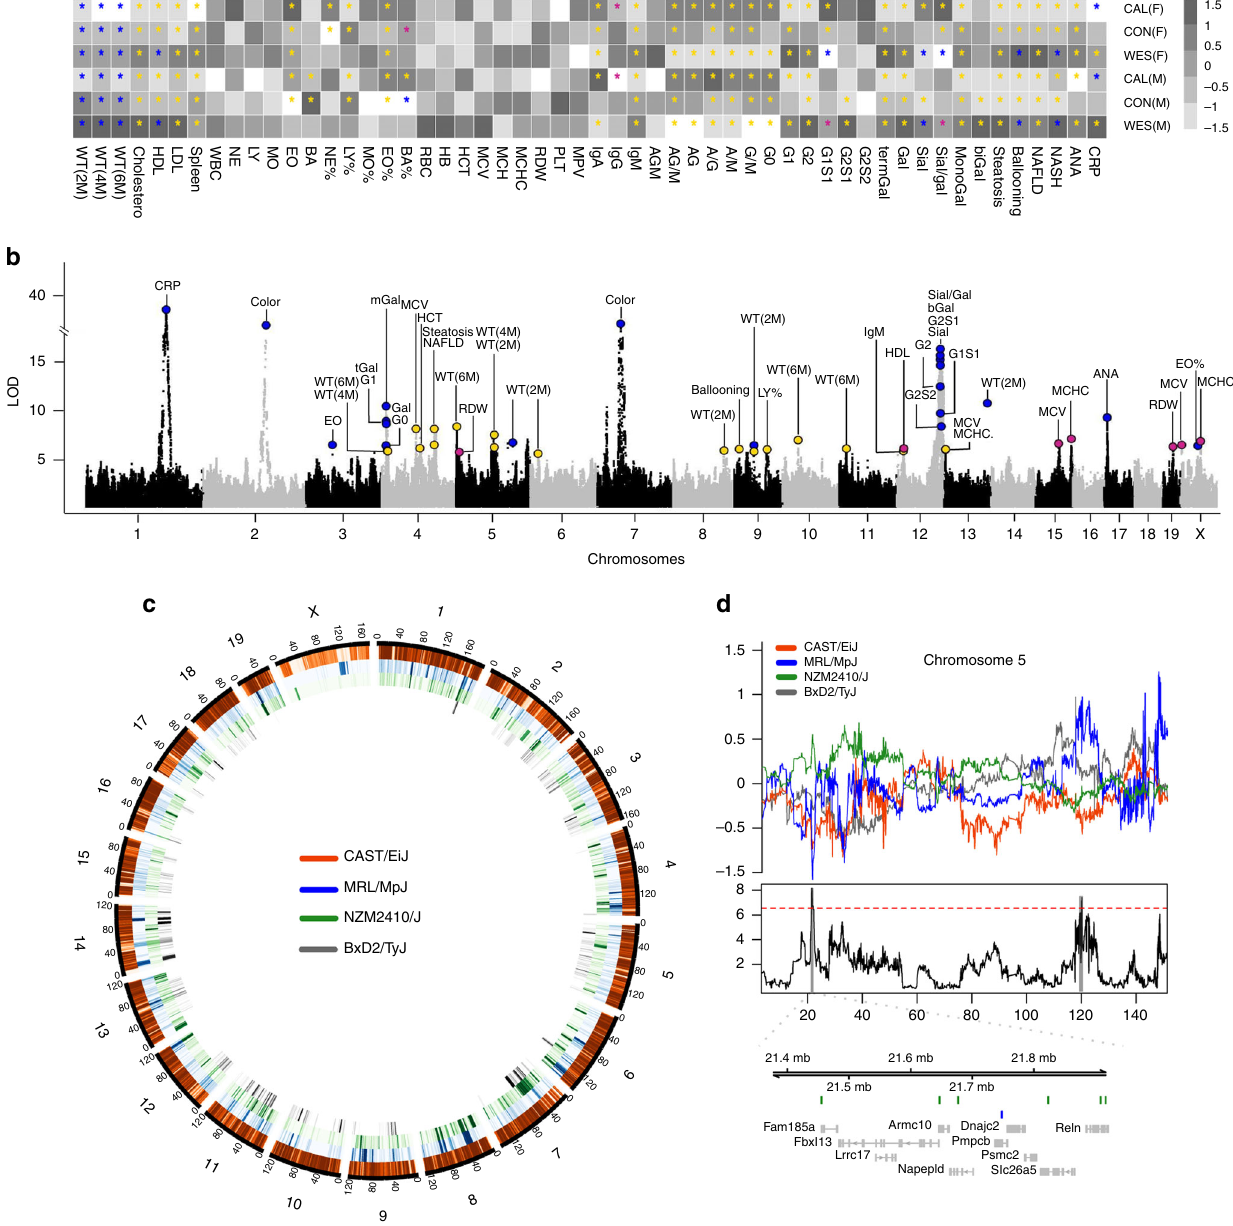
Fig. 1 Phenotyping, QTL identi fi cation, and fi ne mapping of dietary perturbations in an AIL mouse population. a Heatmap illustrating distribution (normalized between 1.5 to − 1.5) of the investigated complex traits in AIL mice for the three dietary regimens in both sexes. Data were analyzed using Kruskal – Wallis test followed by Dunn ’ s test for multiple comparisons (P-value was adjusted by Sidak correction procedure). For binary phenotypes (ANA and NASH), chi-square test was performed followed by Fisher exact test for multiple comparisons where p-values were adjusted by Benjamini-Hochberg correction procedure. The asterisk (*) within each box indicates statistical signi fi cance (Padj < 0.05), whereas the different color codes indicate the association of the particular trait with either diet (yellow), sex (pink) or both (blue). Extension of the abbreviations of the traits and their sample size ( n ) are provided in Supplementary table 1. b Manhattan plot showing QTL ( α gw < 0.05) in the AIL population associated with various complex traits. The x -axis describes chromosomes in the C57BL/6J mouse genome (reference mouse assembly mm10), while the y -axis represents the LOD score (log of odds ratios). The QTL marked with blue represent the additive model, while gold and pink represent diet- and sex-interacting QTL, respectively. c An overview of variants called from 4 founder mouse strains (BxD2/TyJ, MRL/MpJ, NZM2410J, and CAST/EiJ) compared to the C57BL/6J mouse genome reference assembly (mm10). Each track in the circle indicates the relative density of single nucleotide polymorphisms (SNPs) and insertions and deletions (indels) for four strains across mouse chromosomes. d Schematic representation of fi ne-mapped genes for weight (6 months) under the in fl uence of diet using whole- genome sequencing. The uppermost panel shows founders coef fi cients for signi fi cant QTL in chromosome 5. The middle panel shows a line plot for QTL with a red line indicating a genome-wide signi fi cance level ( α gw < 0.05). The lowermost panel shows the genes present within the QTL and variants differing between NZM2410/J and MRL/MpJ strains, leading to the exclusion of several candidate genes. Source data for ( a ) are provided in the Source Data fi le